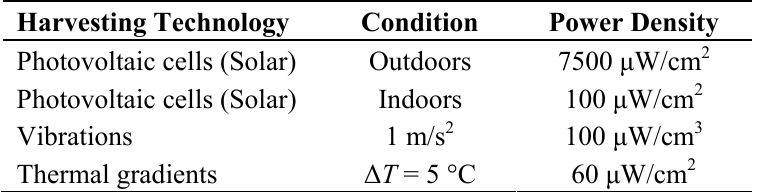
Table 1. Energy-harvesting characteristics